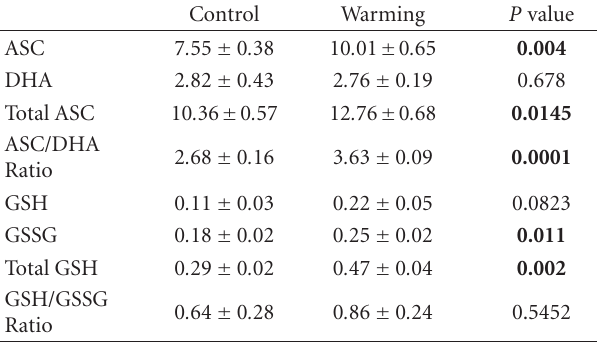
Table 1: Contents of the ascorbate and glutathione related to the fresh weight: reduced ascorbate (ASC), oxidised ascorbate (DHA), total ascorbate (all expressed as μ molg − 1 f.w.), and ascorbate ratio (ASC/DHA); reduced glutathione (GSH), oxidised glutathione (GSSG), total glutathione (all expressed as μ molg − 1 f.w.), and glutathione ratio (GSH/GSSG) in poplar leaves under control and warming treatments. Mean ± SE is shown. Di ff erences between means of control and treated leaves are shown with the P value. Significant value is with P < 0 . 05. The activities of antioxidant enzymes were related to the leaf protein content whereas the ascorbate and glutathione contents were related to the fresh